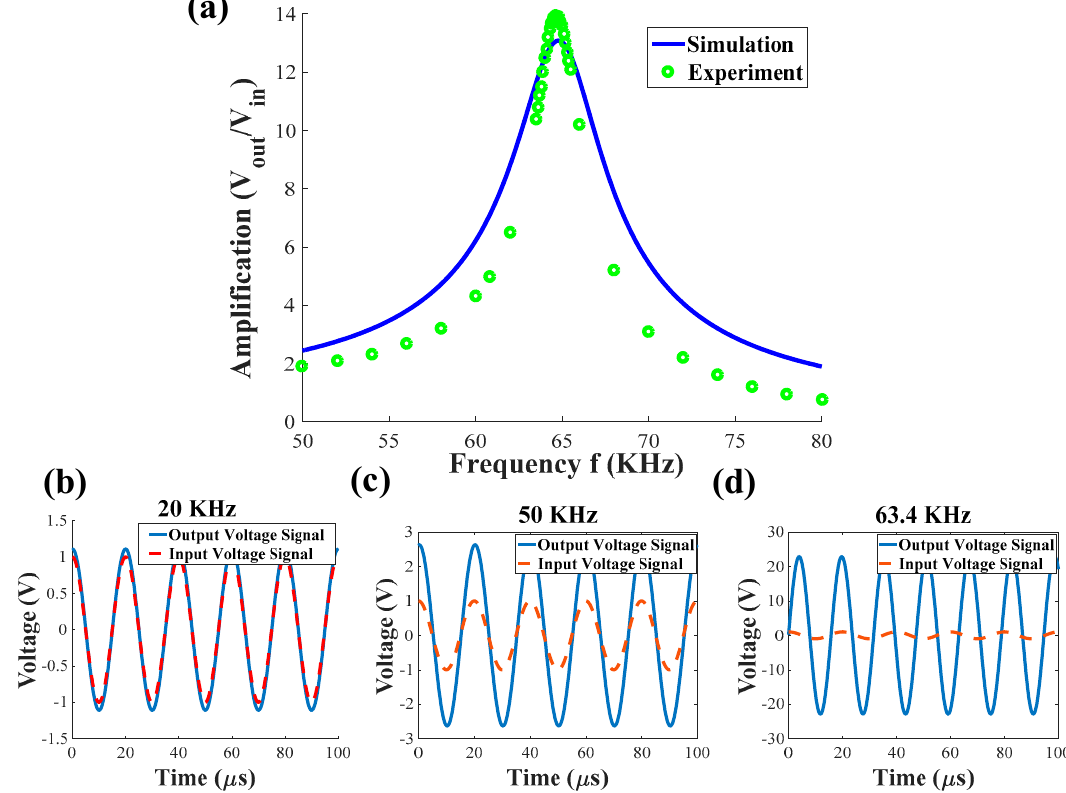
Figure 4. Theoretical and experimental study of the electrical circuit identification and the electrical resonance of the MEMS device in the resonance RLC circuit. ( a ) Circuit frequency response is showing the amplification (gain) of the voltage across the capacitance. The green circles show the experimental voltage across the MEMS device while the solid blue line shows the model simulation results. The electrical resonant frequency and voltage amplification were found to be 64.6 kHz and 13 times, respectively. Furthermore, the time history of the input signal and the output signal at different input frequency values are shown in ( b – d ). A phase shift is observed between the input signal and the output signal at 63.4 kHz, which is a characteristic of the electrical resonance of the system.